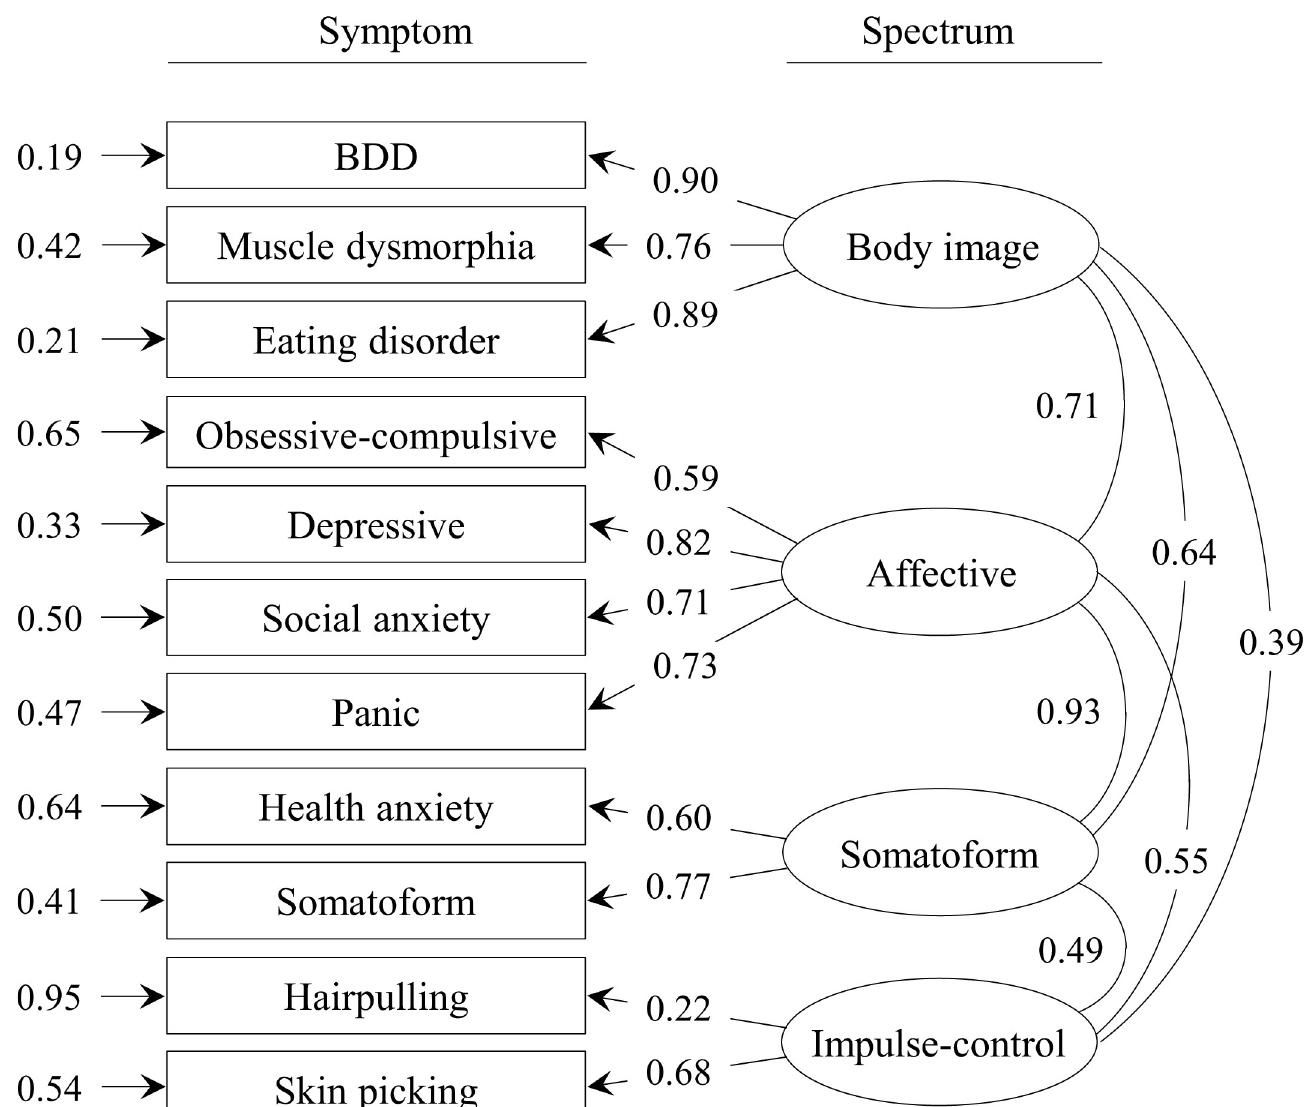
Fig 2. Completely standardized parameter estimates for the body image